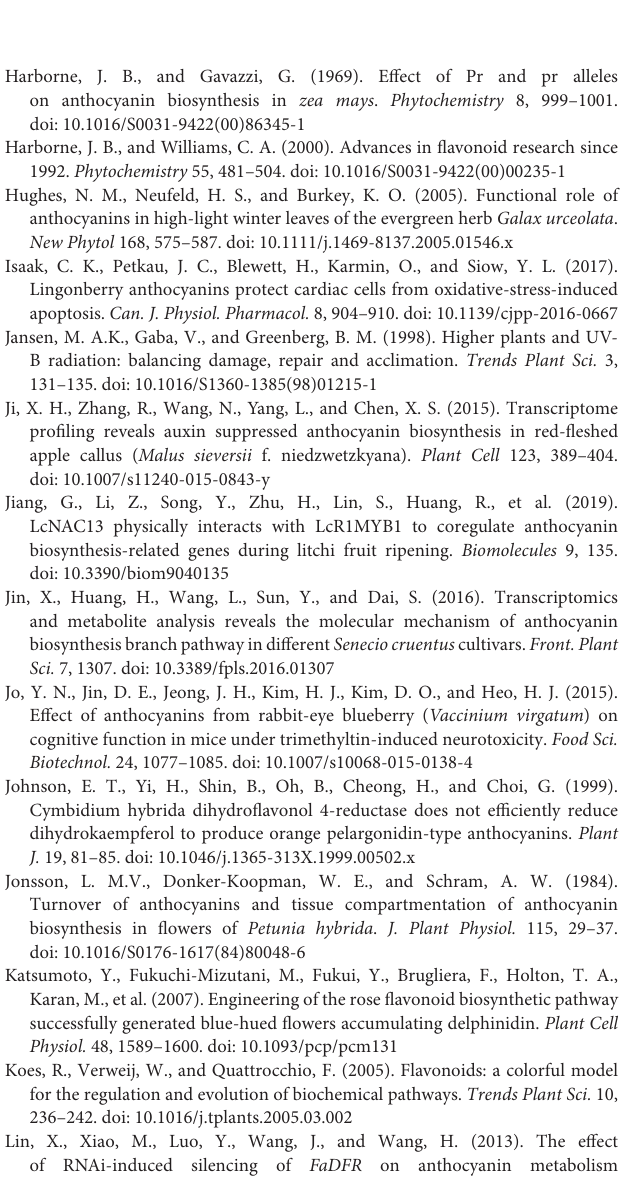
Supplementary Figure S1 | Principal component analysis of the metabolome samples. Supplementary Figure S2 | Heat map of the metabolic profiling. Supplementary Figure S3 | OPLS-DA model plots. Supplementary Figure S4 | KEGG Pathway classification and functional enrichment of DEMs. Supplementary Figure S5 | Pearson correlation between eight libraries. Supplementary Figure S6 | GO functional analysis and classification of DEGs.